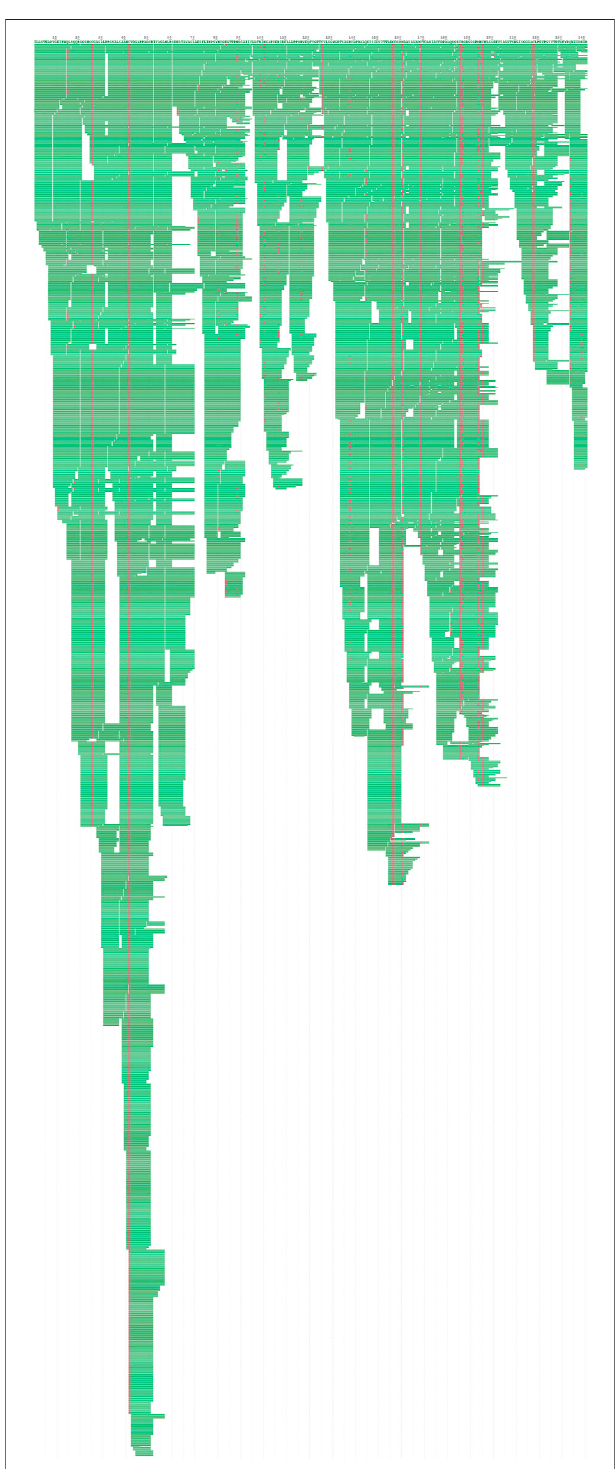
FIGURE 2 | The de novo identi fi ed sequence and coverage of